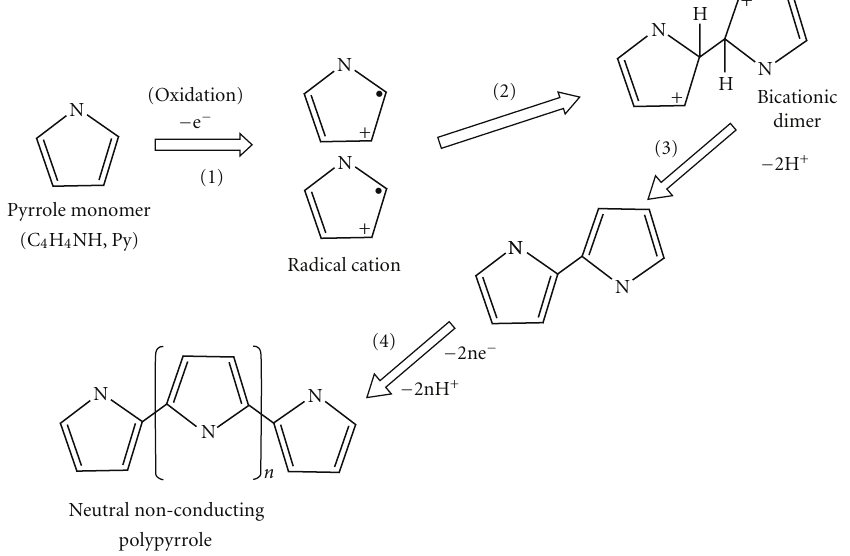
Figure 2: Electropolymerization process of